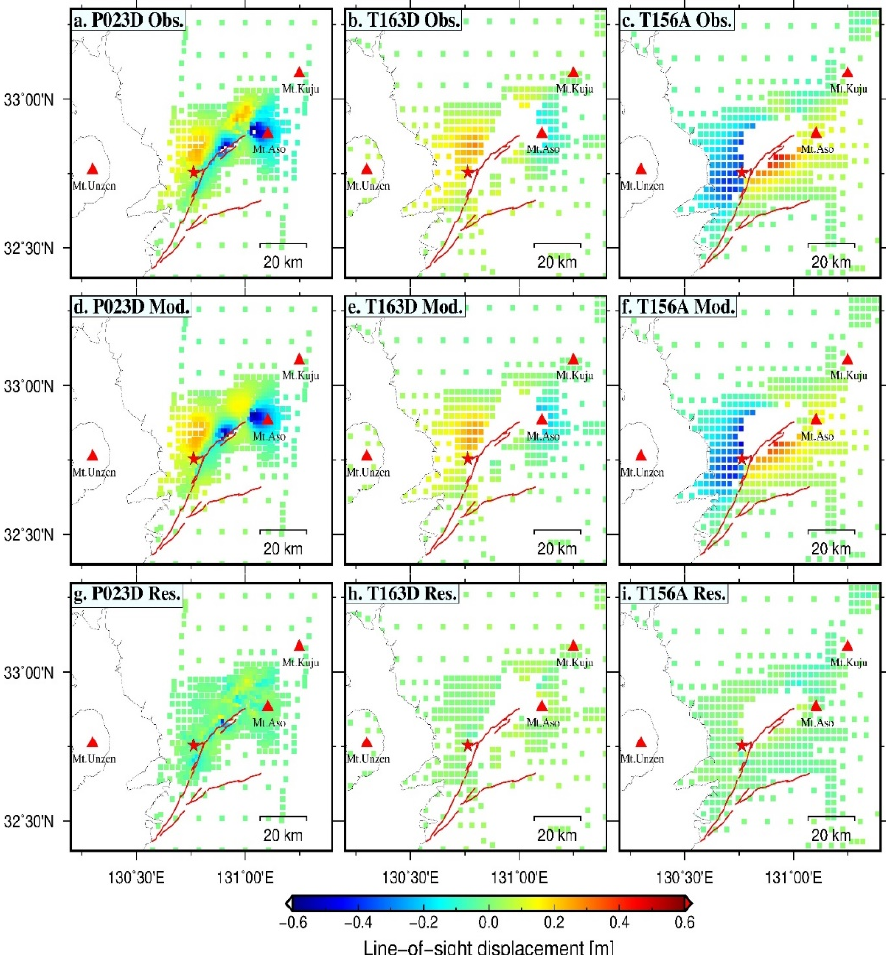
Figure 6. Observed and model-predicted InSAR data and the residuals. ( a–c ) Subsampled InSAR line-of-sight displacement data used in the inversion for ALOS-2 descending track P023D, Sentinel-1A descending track T163D, and ascending track T156A, respectively. ( d–f ) Model-predicted InSAR line-of-sight displacements corresponding to ( a–c ) from our preferred model. ( g–i ) Residuals after subtracting the model predictions from the observations. Positive value indicates the LOS displacement moving toward the